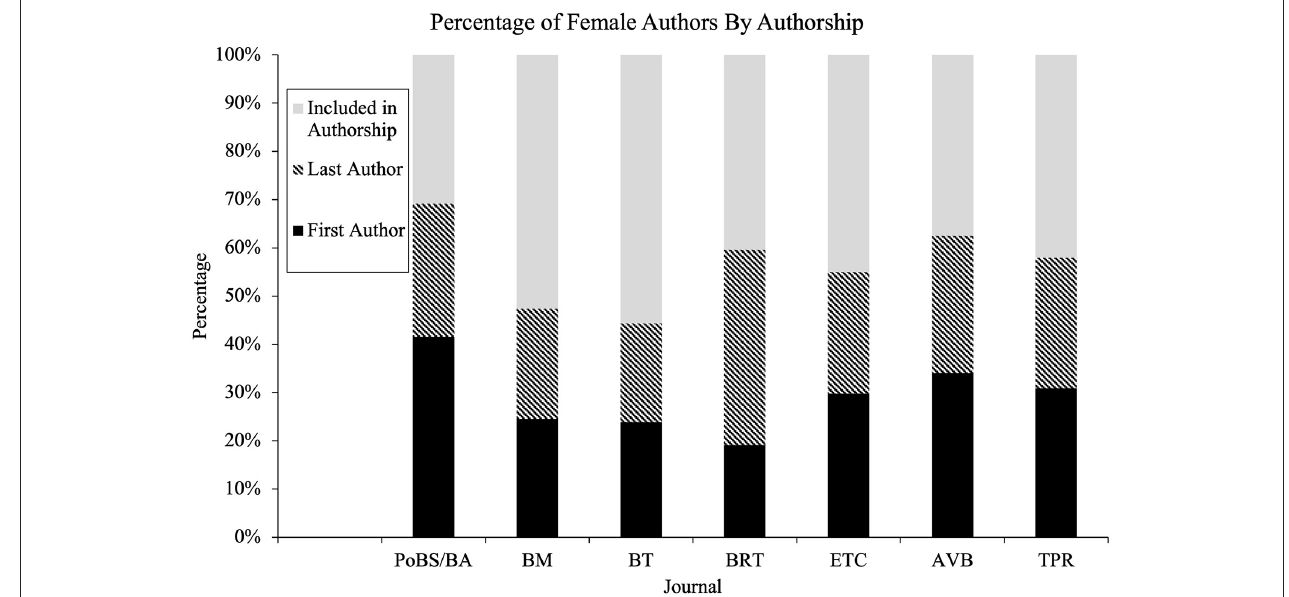
FIGURE 2 | Percentage of female authors by authorship positions by year.